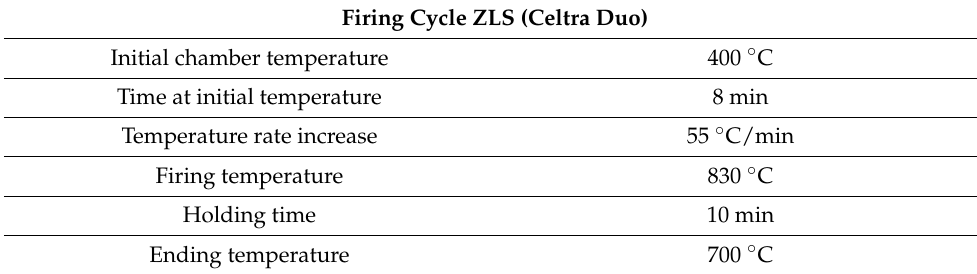
Table 3. Mandatory crystallization cycle according to manufacturer of LD.